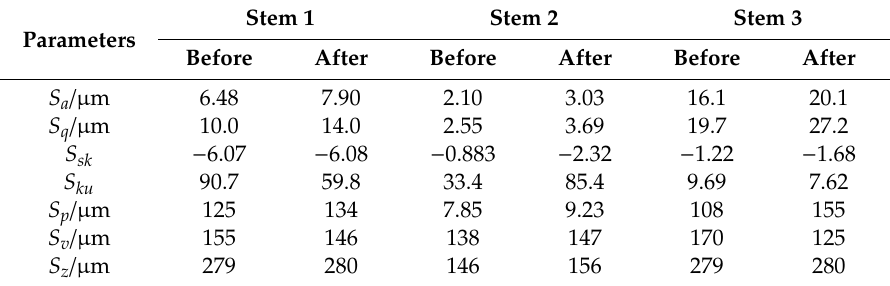
Table 1. Height parameters of green bamboo stems before and after plasma treatment. Stem 1 Stem 2 Stem 3 Parameters Before After Before After Before After S a / µ m